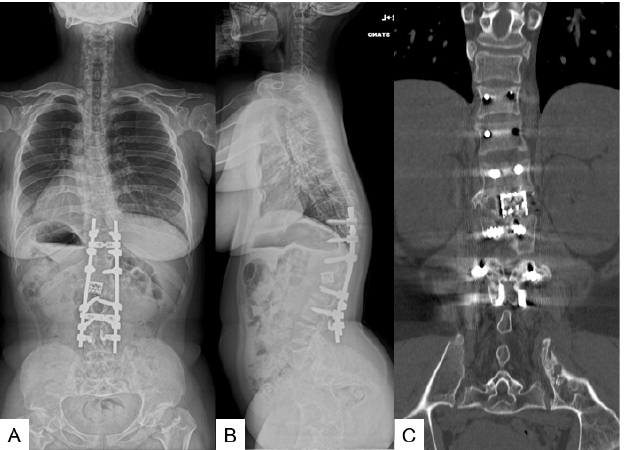
Figure 5. A 16-year-old girl with achondroplasia; final follow-up images. ( A ) Posteroanterior radi- ogram; ( B ) lateral radiogram; ( C ) coronal reconstruction CT. T11-L2 local kyphosis 14°; SVA 31 mm; PT 16°; PI 52°.